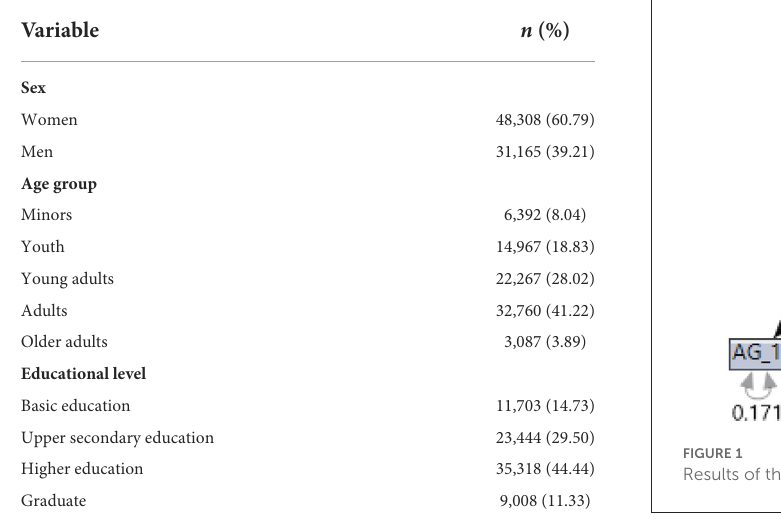
TABLE 1 Sociodemographic characteristics of the sample.